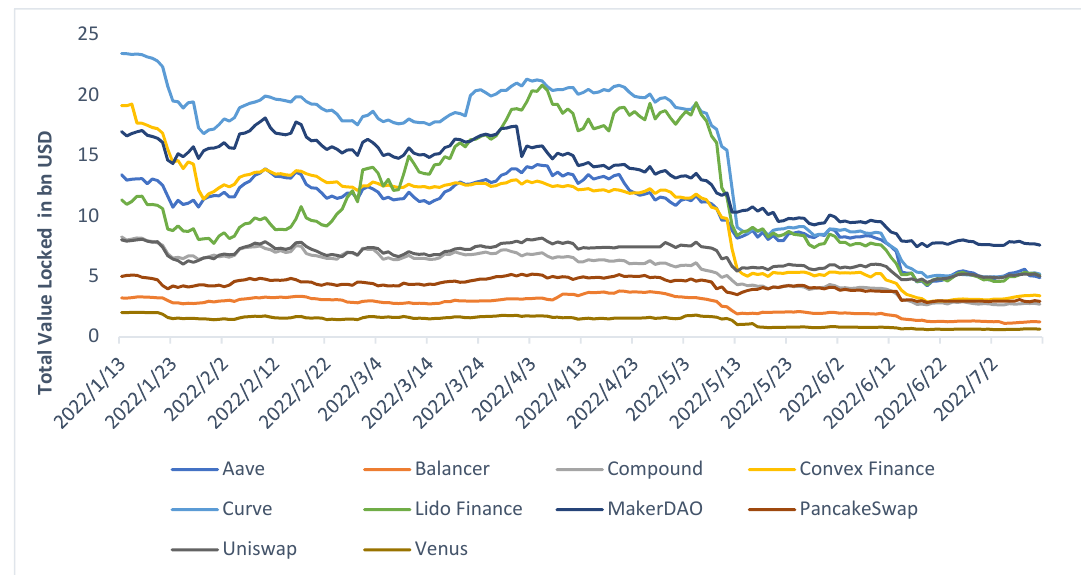
Figure 2. Top 10 dapps based on daily total value locked. Source: own elaboration.